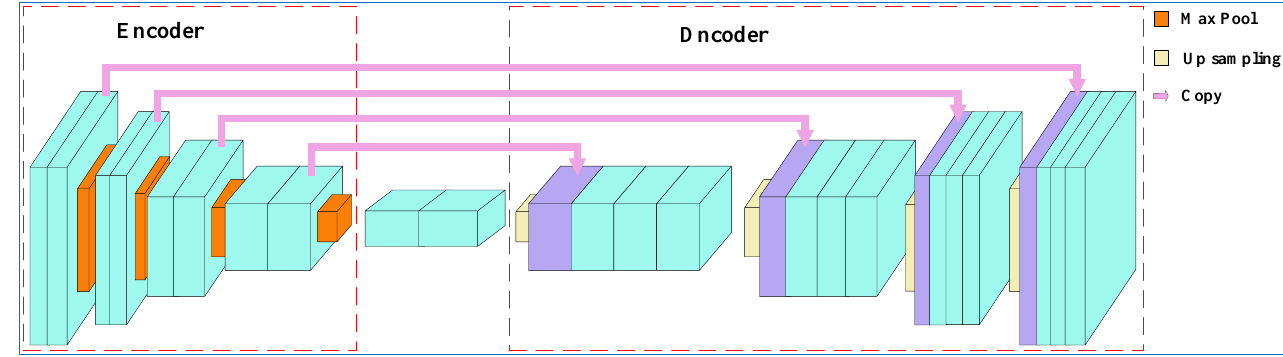
Figure 5. The architecture of